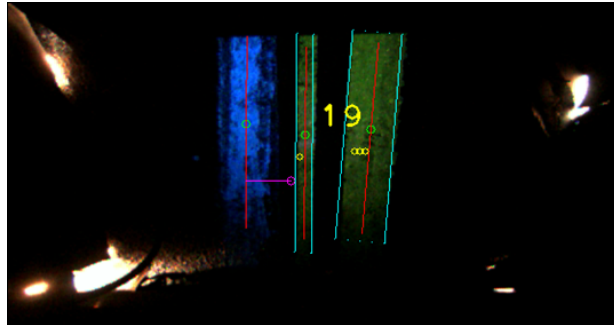
Figure 4. Line and mark detection by the computer vision